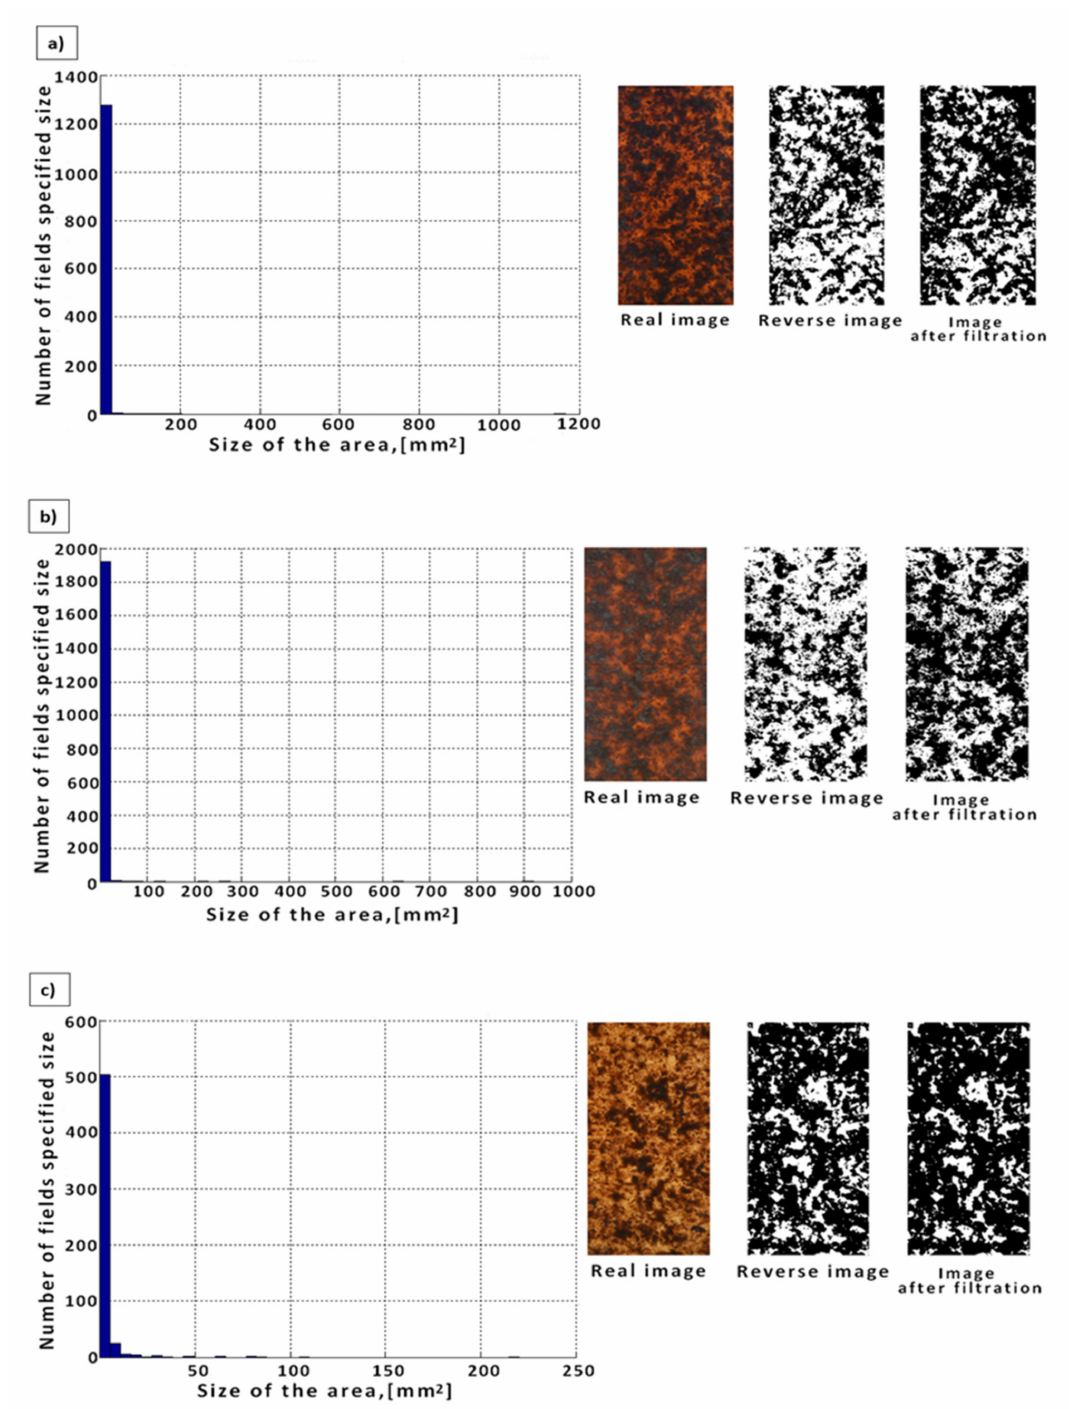
Figure 6. Histogram of the determined numbers and areas of agglomerates for WPCs with the addition of wood flour (PP/Lignocel C120) obtained under the conditions of ( a ) high shear rate values ( γ · = 800 s − 1 ), ( b ) medium shear rate values ( γ · = 400 s − 1 ), and ( c ) low shear rate values ( γ · = 70 s − 1